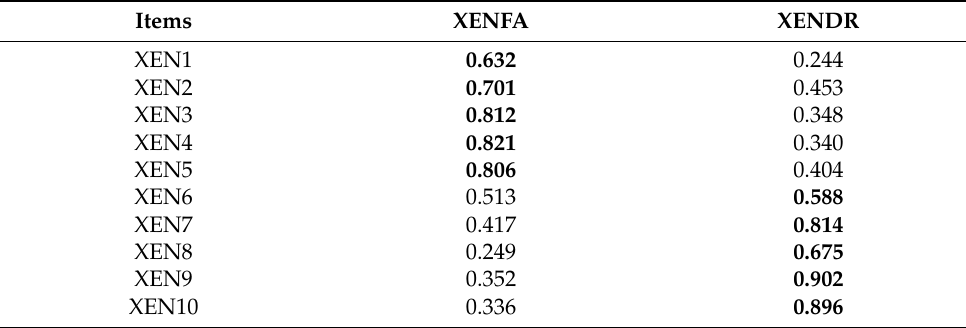
Table 4. Cross-loadings of lower-order model.